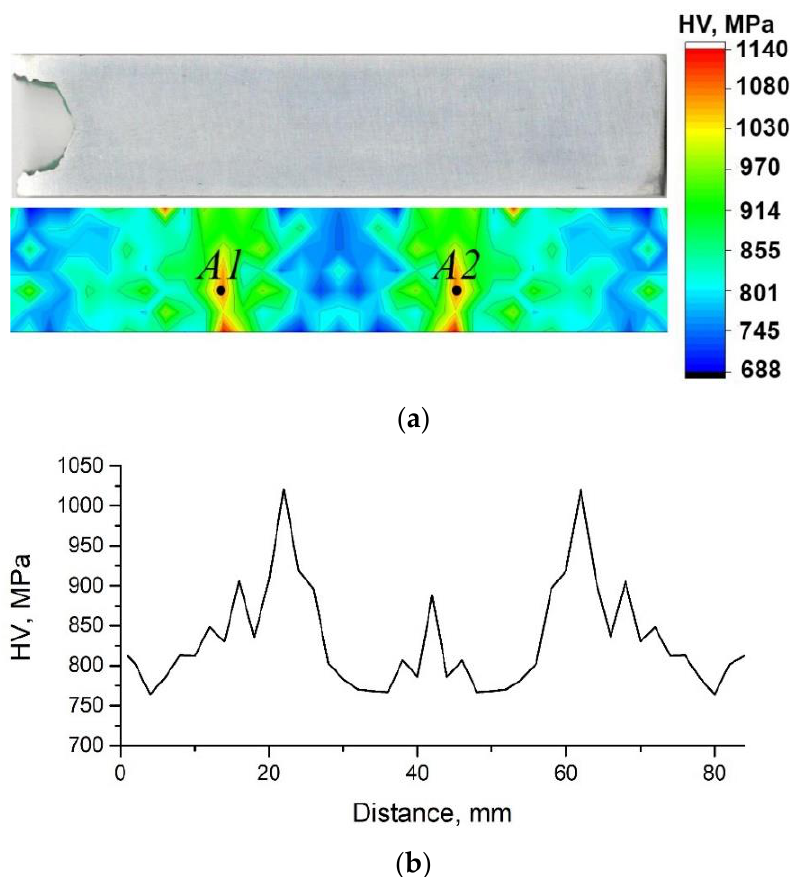
Figure 5. The photograph of the longitudinal section of the specimen and corresponding microhard- ness map of the Mg-Al-Zn alloy after reduction – ECAP and UST ( a ). The values of microhardness averaged over each plane of cross-section on the coordinate x along the sample length ( b ).